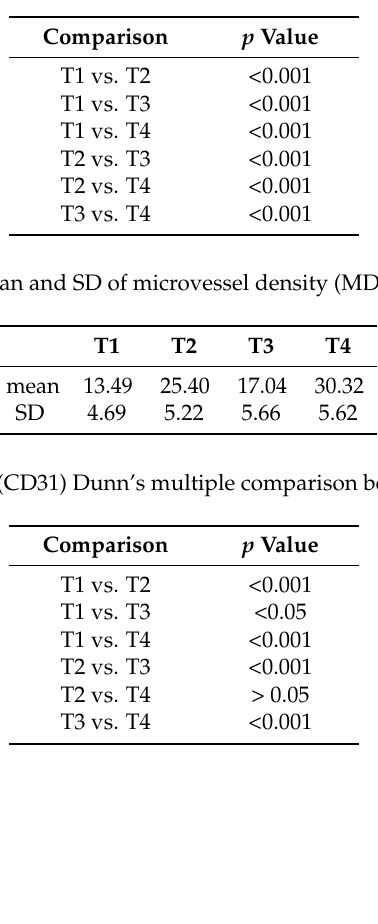
Table 8. CD68 Dunn’s multiple comparison between groups.